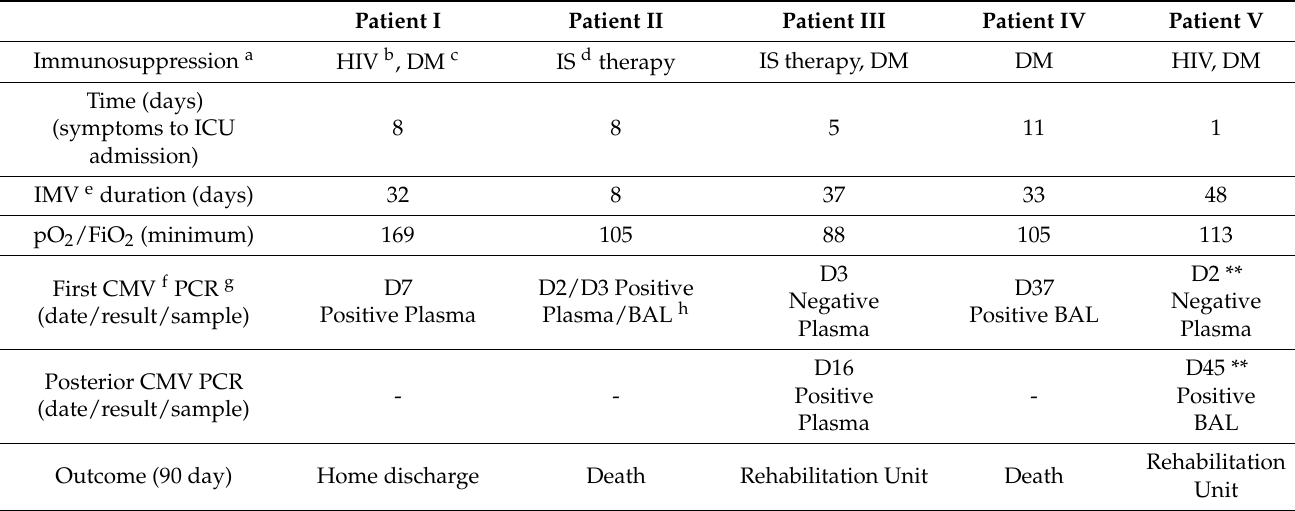
Table 1. Clinical characteristics of patients admitted to the ICU with SARS-CoV-2 infection due to respiratory failure who evolved with CMV